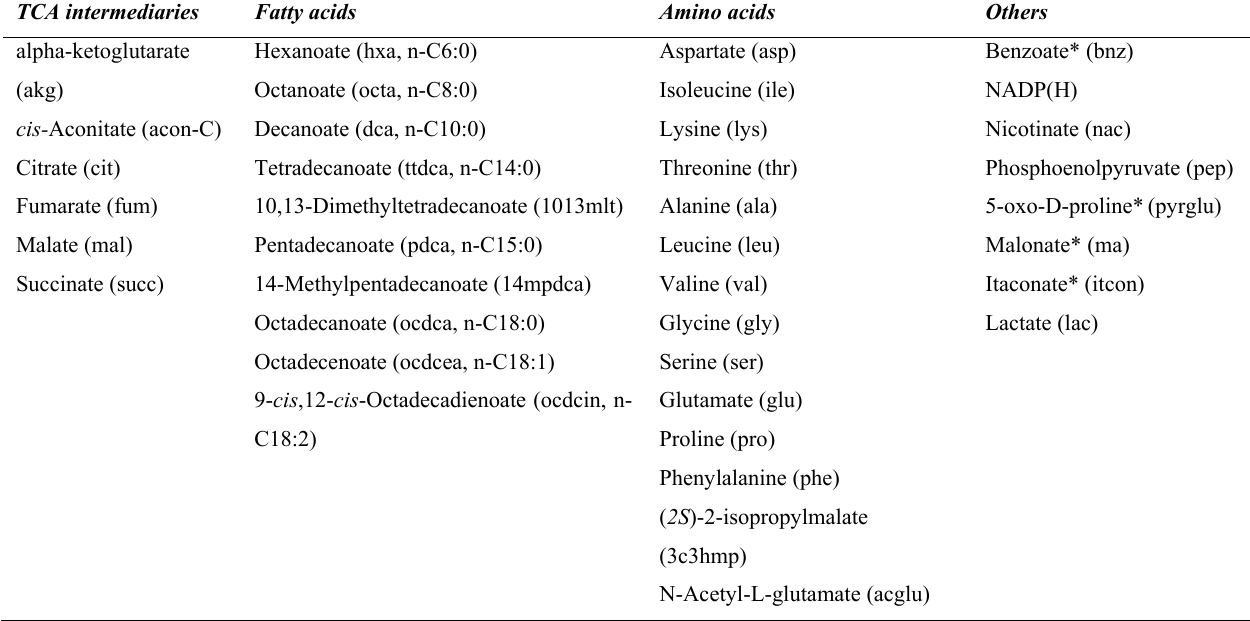
Table 2. List of the intracellular metabolites identified after GC-MS